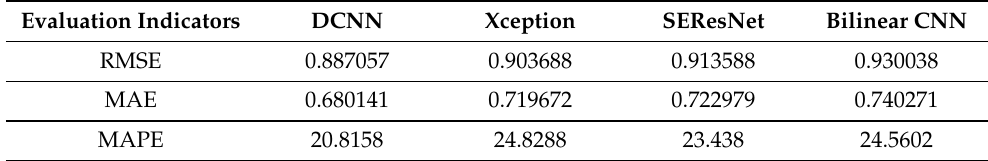
Table 5. Evaluation table for the prediction results of the bilateral dataset.